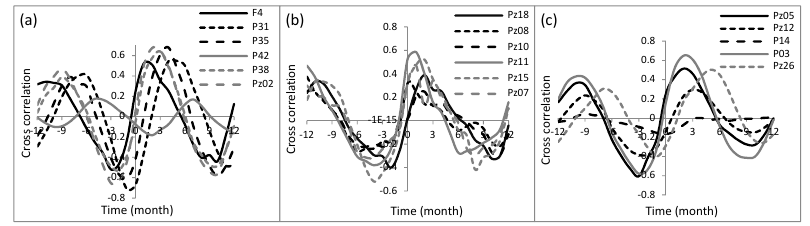
Figure 6. Cross-correlation between rainfall and groundwater level based on a monthly time step between 1995 and 1997: ( a ) upstream Kou catchment piezometers; ( b ) Nasso-Guinguette spring area piezometers; and ( c ) downstream Kou catchment piezometers.